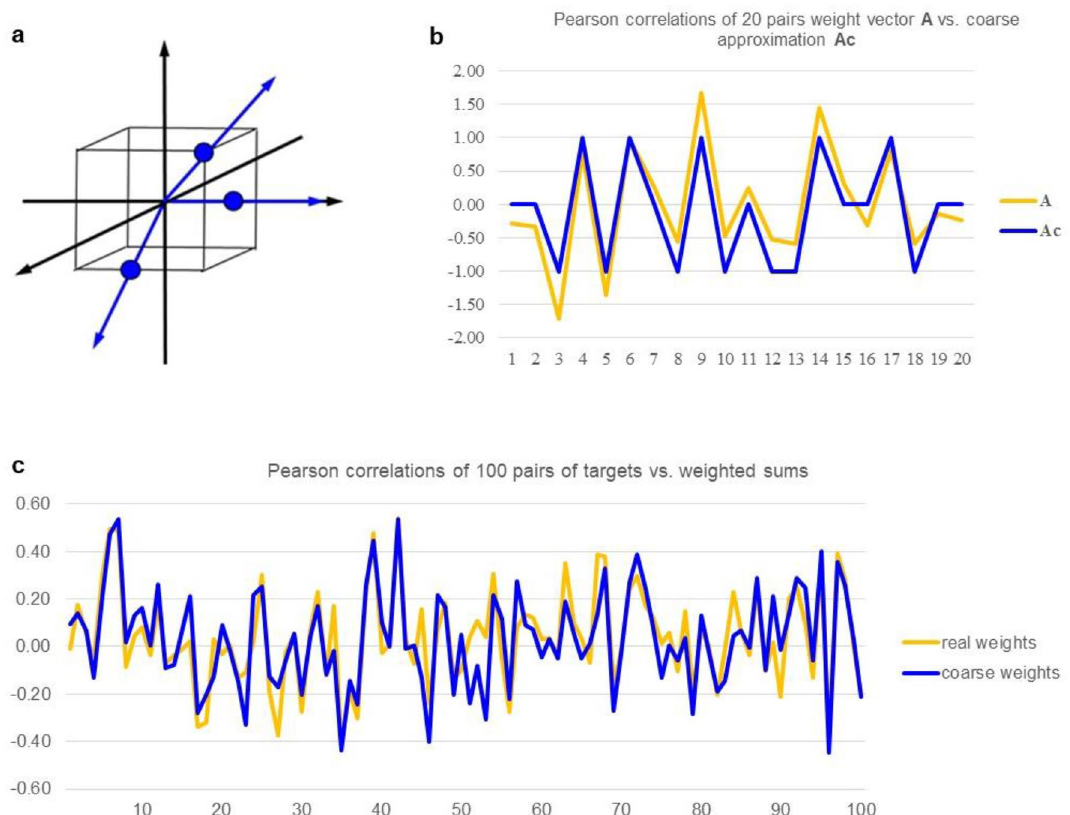
Figure 8. Geometry of CALF and simulations of coarse approximations. ( a ) Three rays (of 26 possible) employed by CALF in 3-dimensional space relate to coordinates of the vertices of the cube (the eight triplets of ± 1). One ray passes through a vertex, one through the midpoint of an edge, and one through the midpoint of a face. ( b ) Visual representation of a typical, single coarse approximations of a real 20-dimensional vector. The real vector A has 20 normally distributed components, mean = 0 and sd = 1; components of the coarse approximations Ac use threshold = ± 0.4307. That is, if a component of A is < 0.4307, then the corresponding component of Ac is − 1, and so on. ( c ) Among 20-dimensional vectors, a plot of 100 comparisons of dot products of A with B versus Ac with B , where A and B are normally distributed, and Ac is the coarse approximation of A